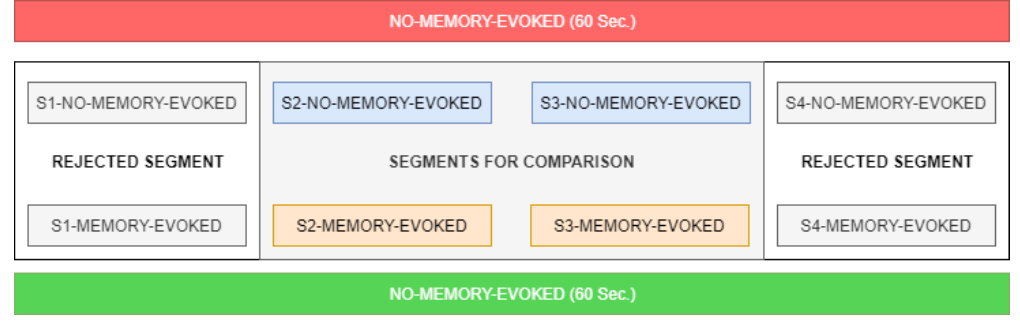
Figure 5. Partitioning of each of the EEG recordings into 15-s segments.